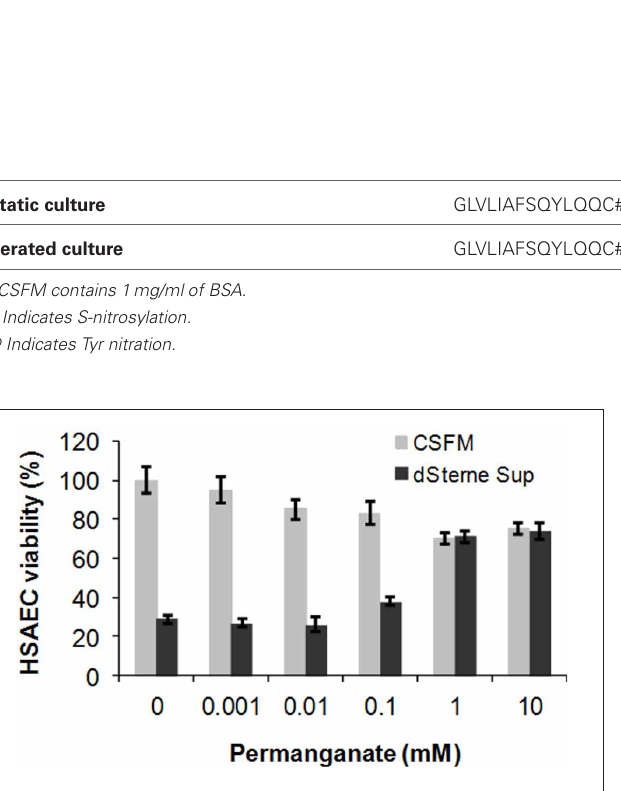
FIGURE 11 | Permanganatetreatment reduces the toxicity of dSterne Sup. The indicated concentrationsof KMnO 4 were added for 1h to the Sup grown in CSFM for 24h, and toxicity of the treated Sup was tested after incubationwithHSAECsfor2h.Errorbarsindicate95%confidenceintervals.